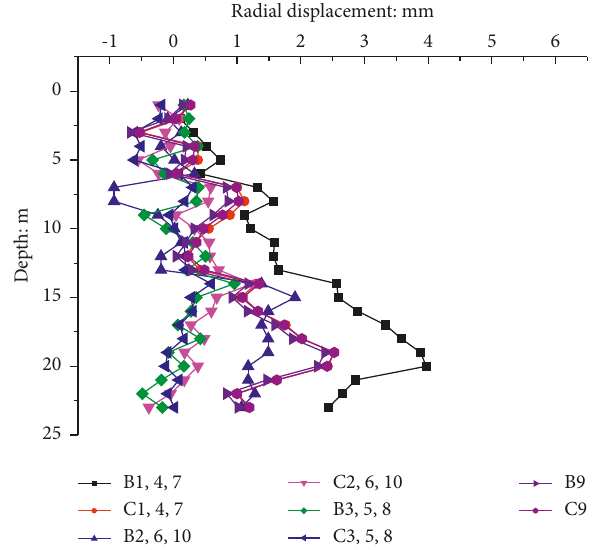
Figure 29: The horizontal displacement of # 2 measuring point changes with